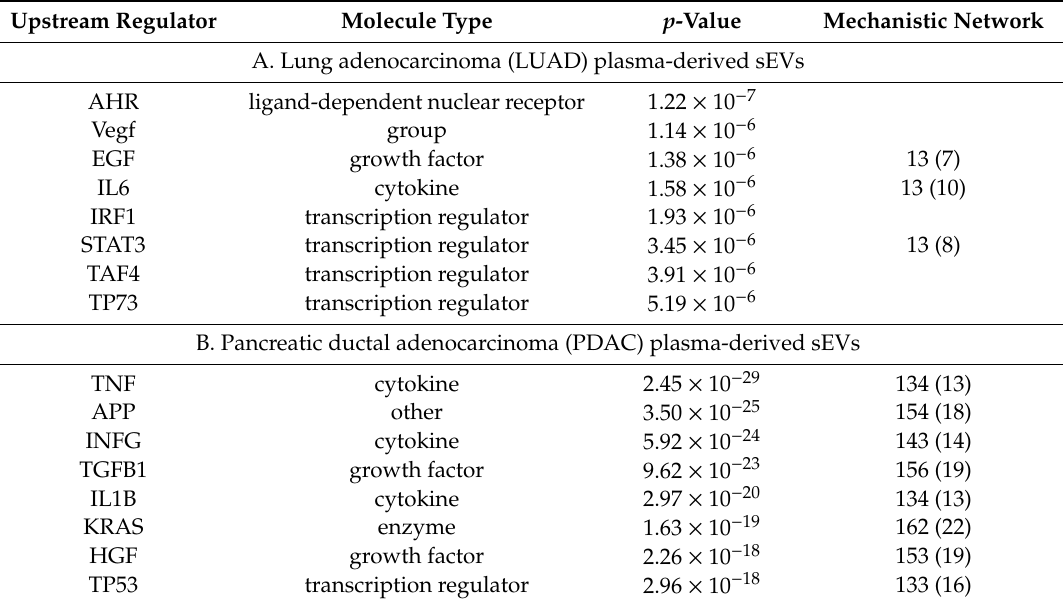
Table A6. Ingenuity Upstream Regulator Analysis of sEV protein features with ROC AUC ≥ 0.7 classifier performance also identified in adenocarcinoma panel cell lines. Top-ranked statistically enriched gene, RNA and protein Upstream